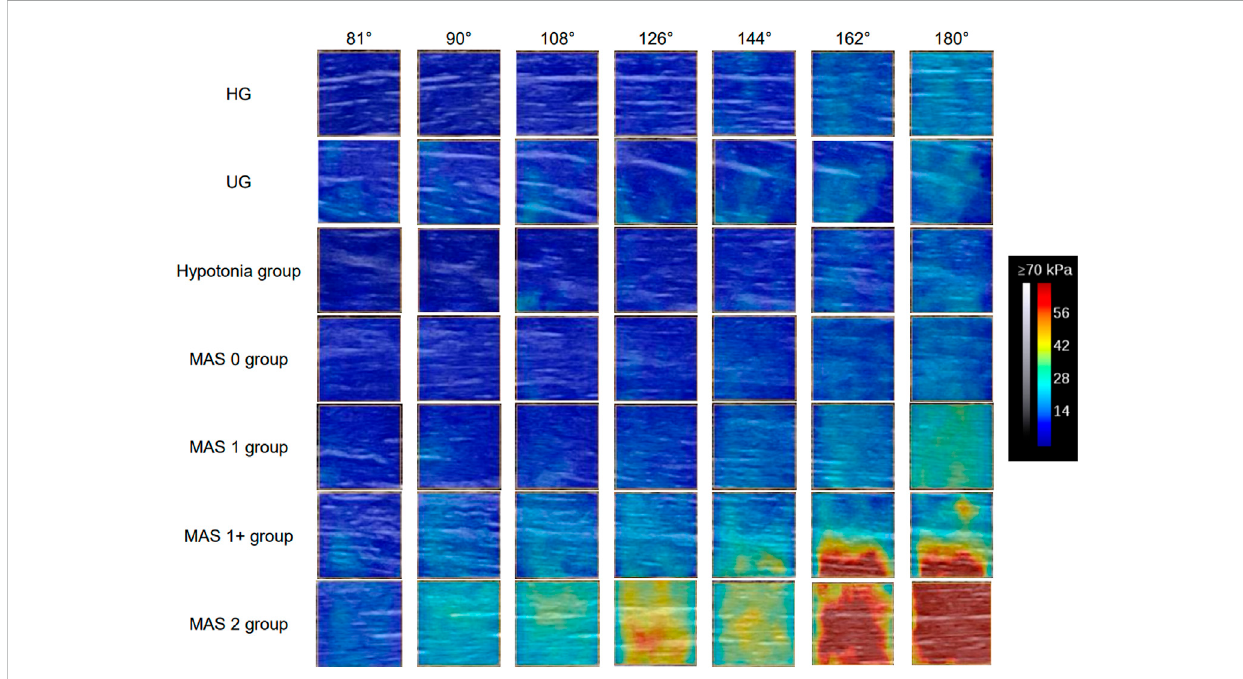
FIGURE 2 Typical SWE images of each observation positions of the participants in each group. The Young ’ s modulus of the biceps brachii increases continuouslyduring theelbow straightening. With theincreaseof muscle tone, thedegree ofincrease of theYoung ’ smodulusbecomes more and